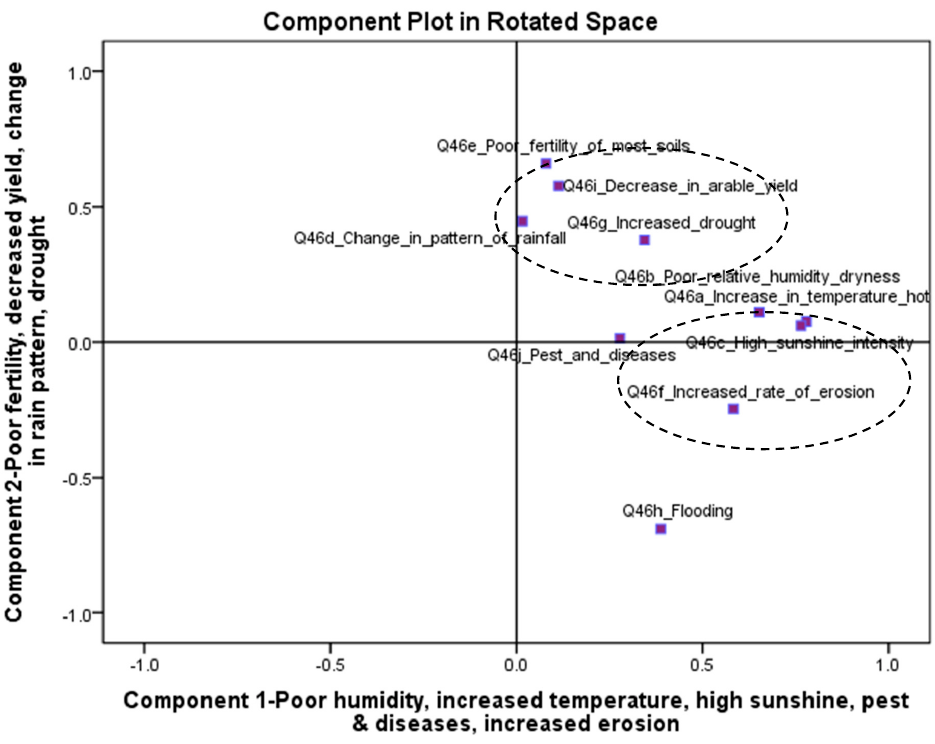
Figure 3. Component plot in rotated space of perception variables for both communities.